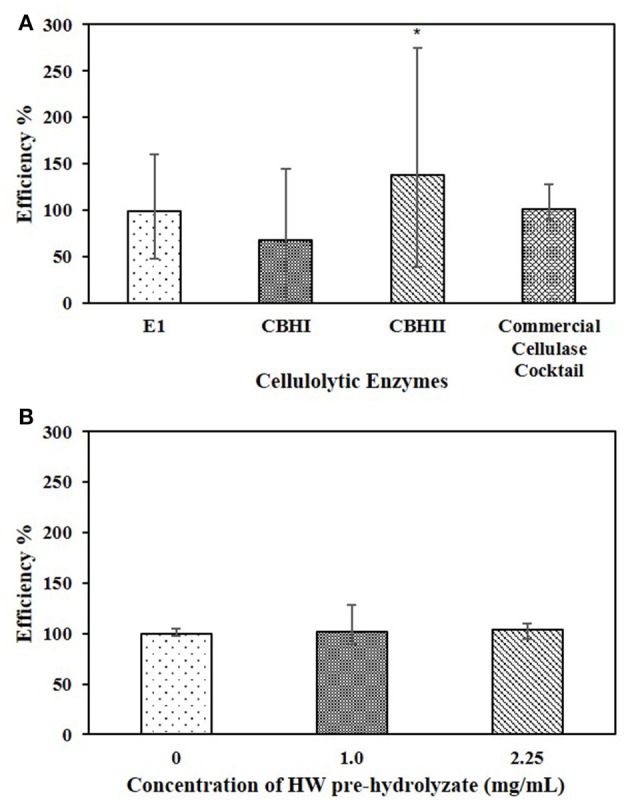
(A) Effects of 1.0 mg/mL whole HW pre-hydrolyzate on E1, CBHI, CBHII, and commercial cellulase cocktail during the cellulose-DNS assay. (B) Effects of different concentration of whole HW pre-hydrolyzate on commercial cellulase cocktail during the cellulose-DNS assay. Symbol * represents the level of significance according to the double tailed t-test. Standard error bars were used to represent the deviation.